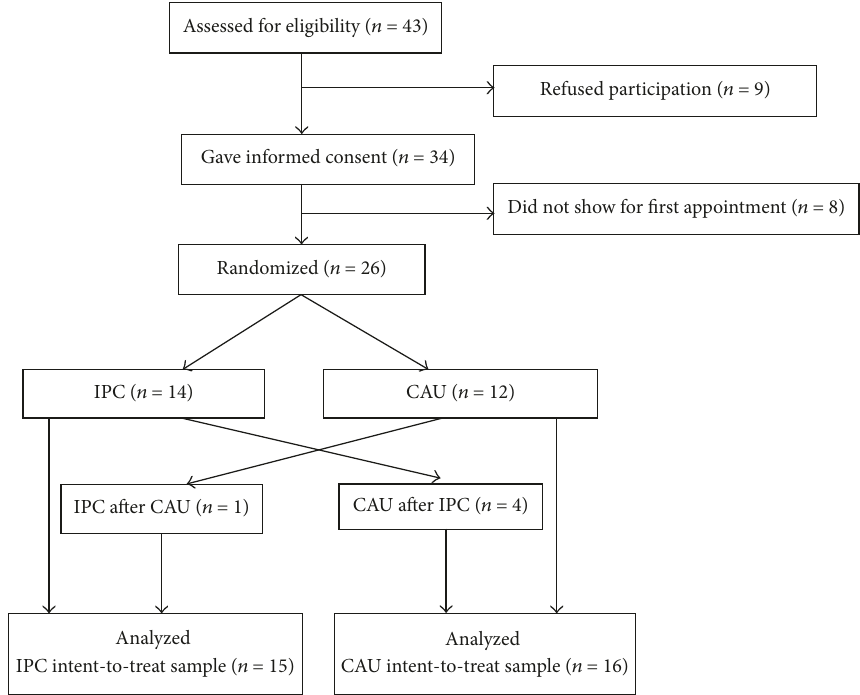
Figure 1: Recruitment and retention of participants. CAU is counseling as usual; IPC is interpersonal counseling.